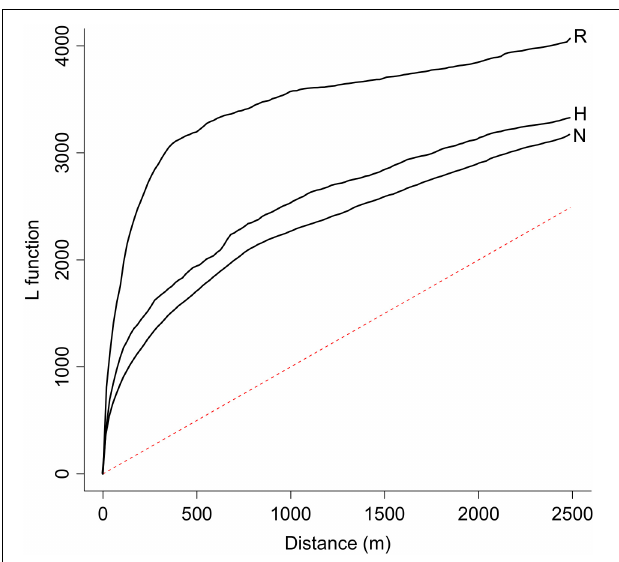
FIGURE 2 | Populations of endangered plant species in Berlin are spatially clustered as indicated by the value of Ripley’s L-function over the entire range of distances between each two populations. The level of clustering is higher for populations located in natural remnant ecosystems (line R, n = 423) than for populations located in hybrid (line H, n = 632) or novel (line N, n = 687) ecosystems. A random spatial Poisson distribution is marked as a red dashed